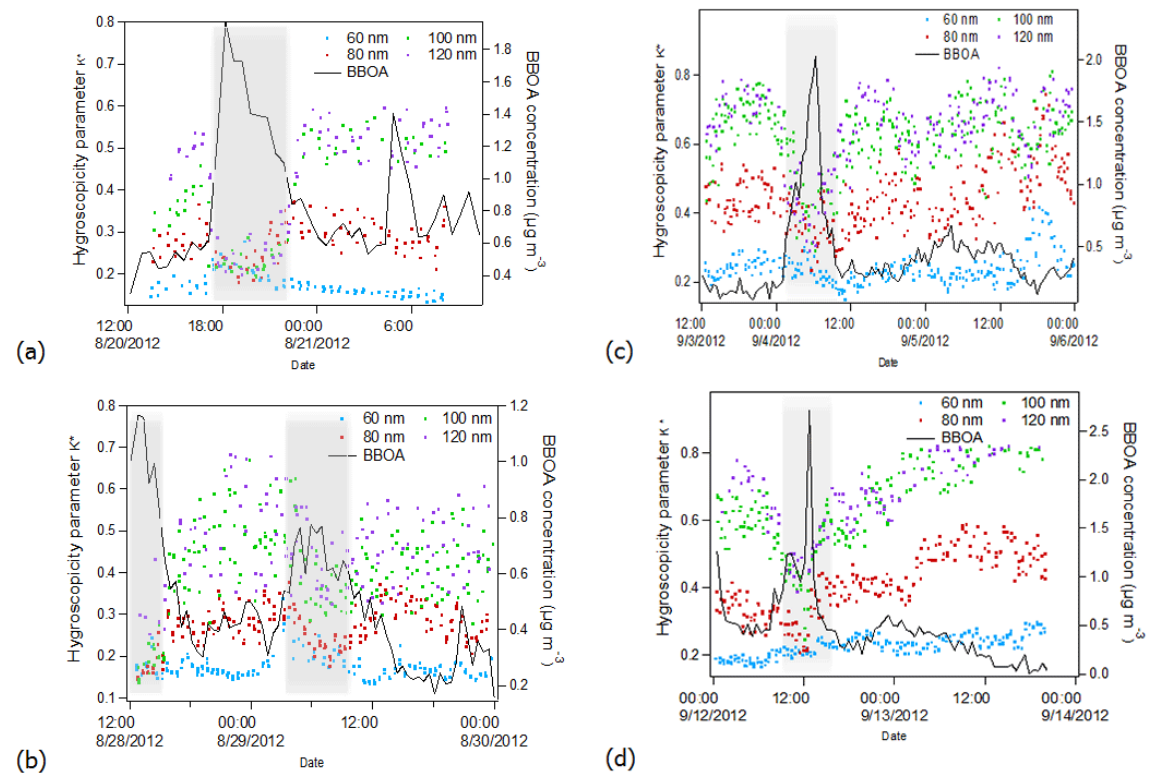
Figure 6. Characteristic hygroscopicity parameters of the selected particle sizes for (a) Chios, (b) Croatia, (c) Euboea and (d) Andros. The solid line represents the biomass-burning component of the organic aerosol at the given time and the shaded areas represent the smoke plume influence period.